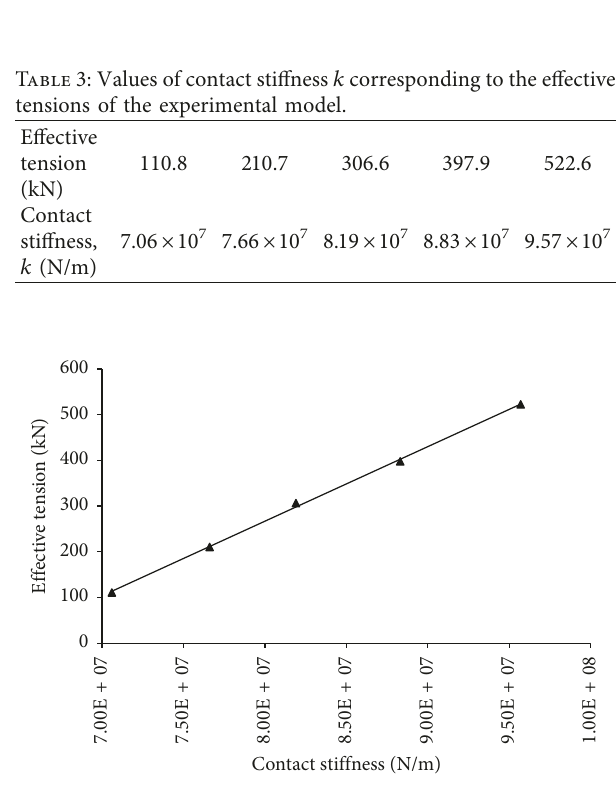
Figure 14: Relation between the contact stiffness k and effective tension for the experimental model.